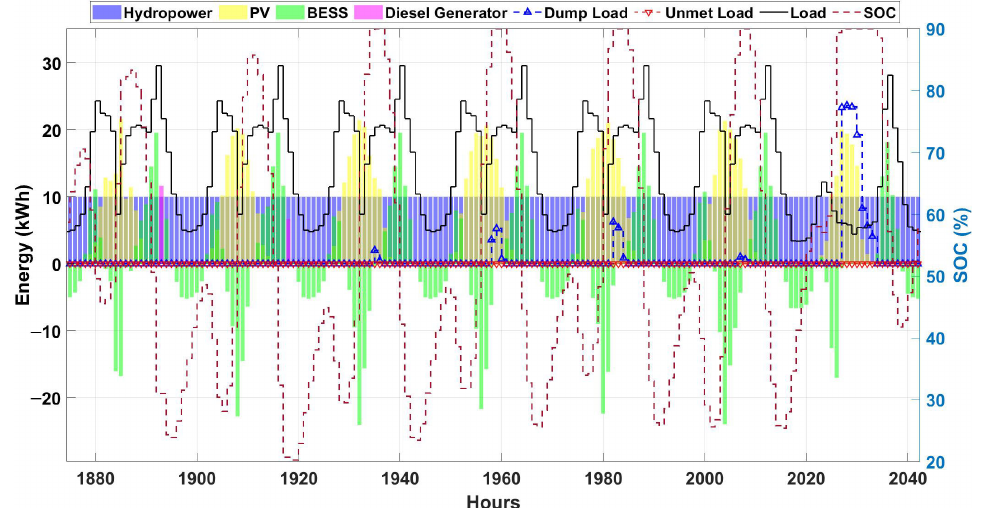
Figure 22. Energy scheduling—Scenario 4—with agricultural load and high solar